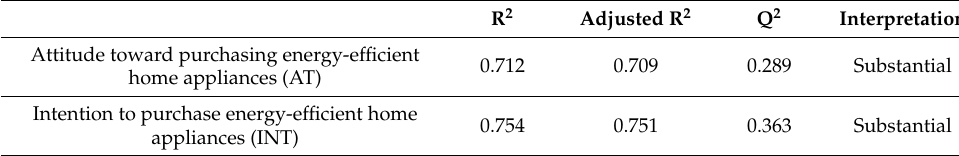
Table 5. Results of R 2 and Q 2 .